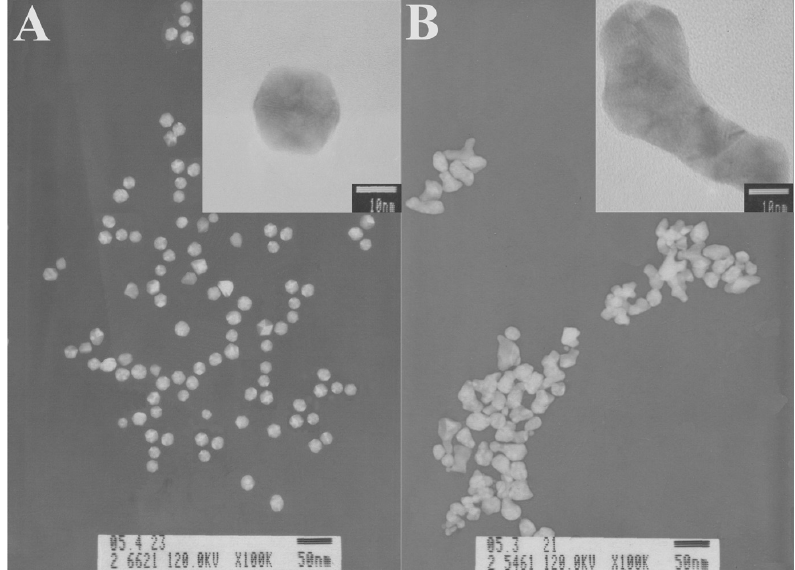
Figure 1. TEM images of (A) hexagon- and (B) boot-shaped gold nanoparticles prepared using the present synthetic route. Their insets are the corresponding TEM images of single gold nanoparticles, respectively. Scale bars: 50 nm and 10 nm